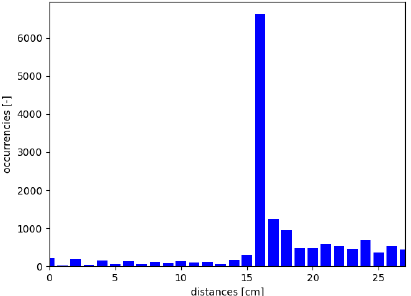
Figure 6: Histogram of distances resulting from the statistical